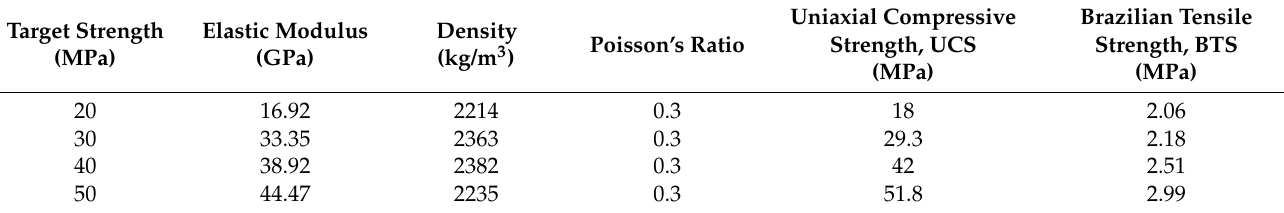
Table 2. Physical and mechanical properties of the model